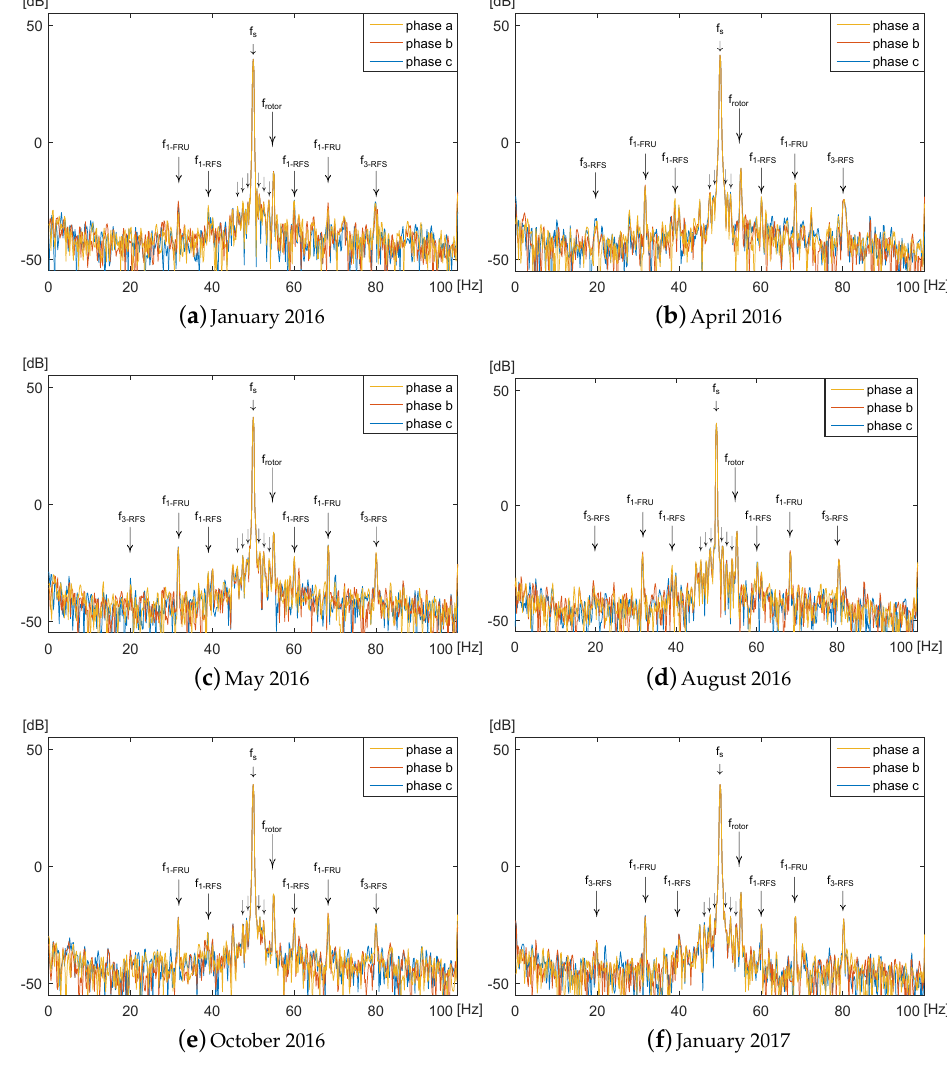
Figure 3. January 2016–January 2017. Evolution of current spectra at super-synchronous